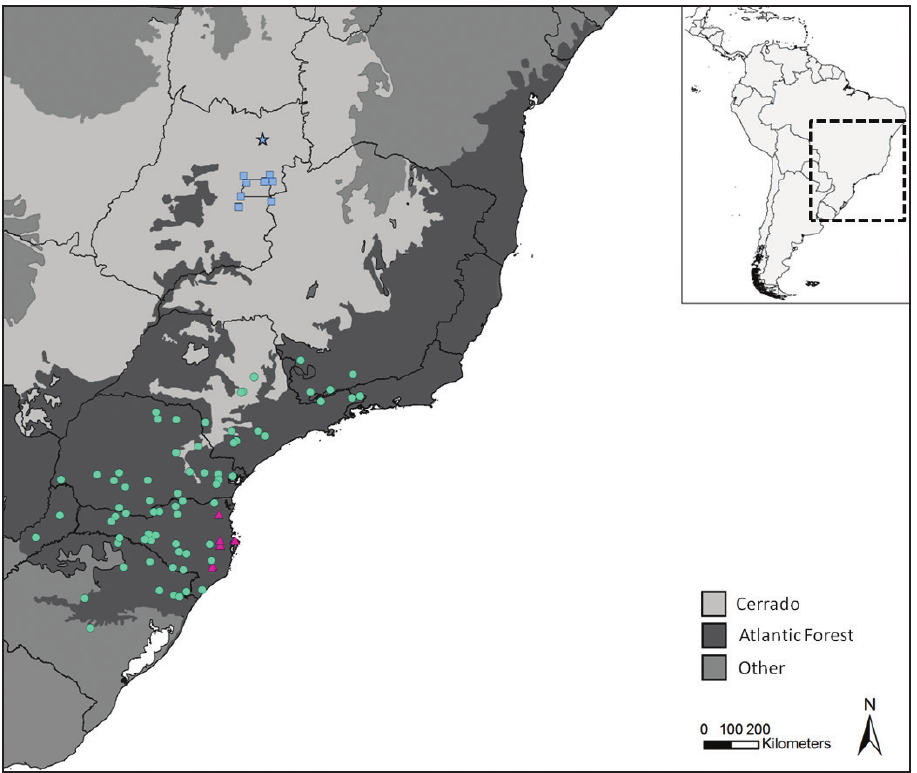
Figure 5. Geographic distribution of Aplastodiscus cochranae (pink triangles), A. perviridis (green circle), and A. lutzorum sp. n. (blue squares, blue star indicates its type-locality). Note that A. lutzorum shows a disjunctive distribution regarding the other Aplastodiscus species, occurring deep within Cerrado